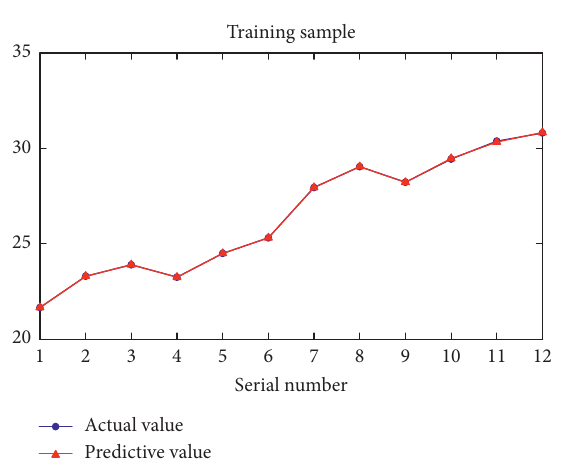
Figure 20: PSO-BP network training sample.